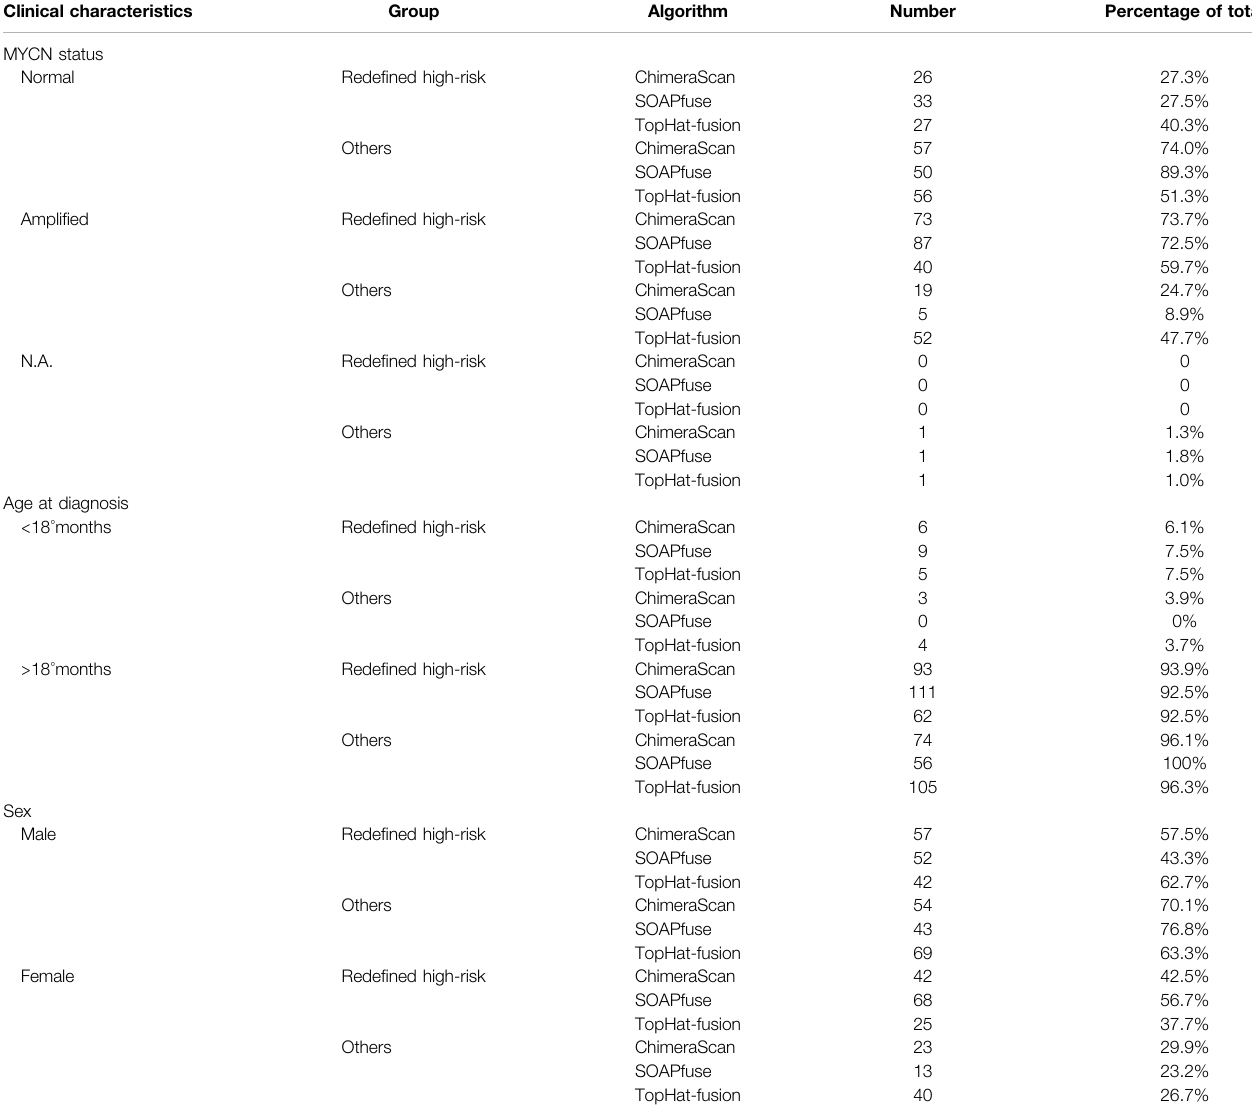
TABLE 2 | Clinical characteristics of rede fi ned high-risk patients Clinical